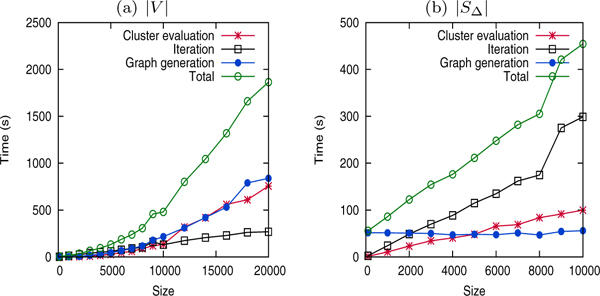
Scalability of FUSE.